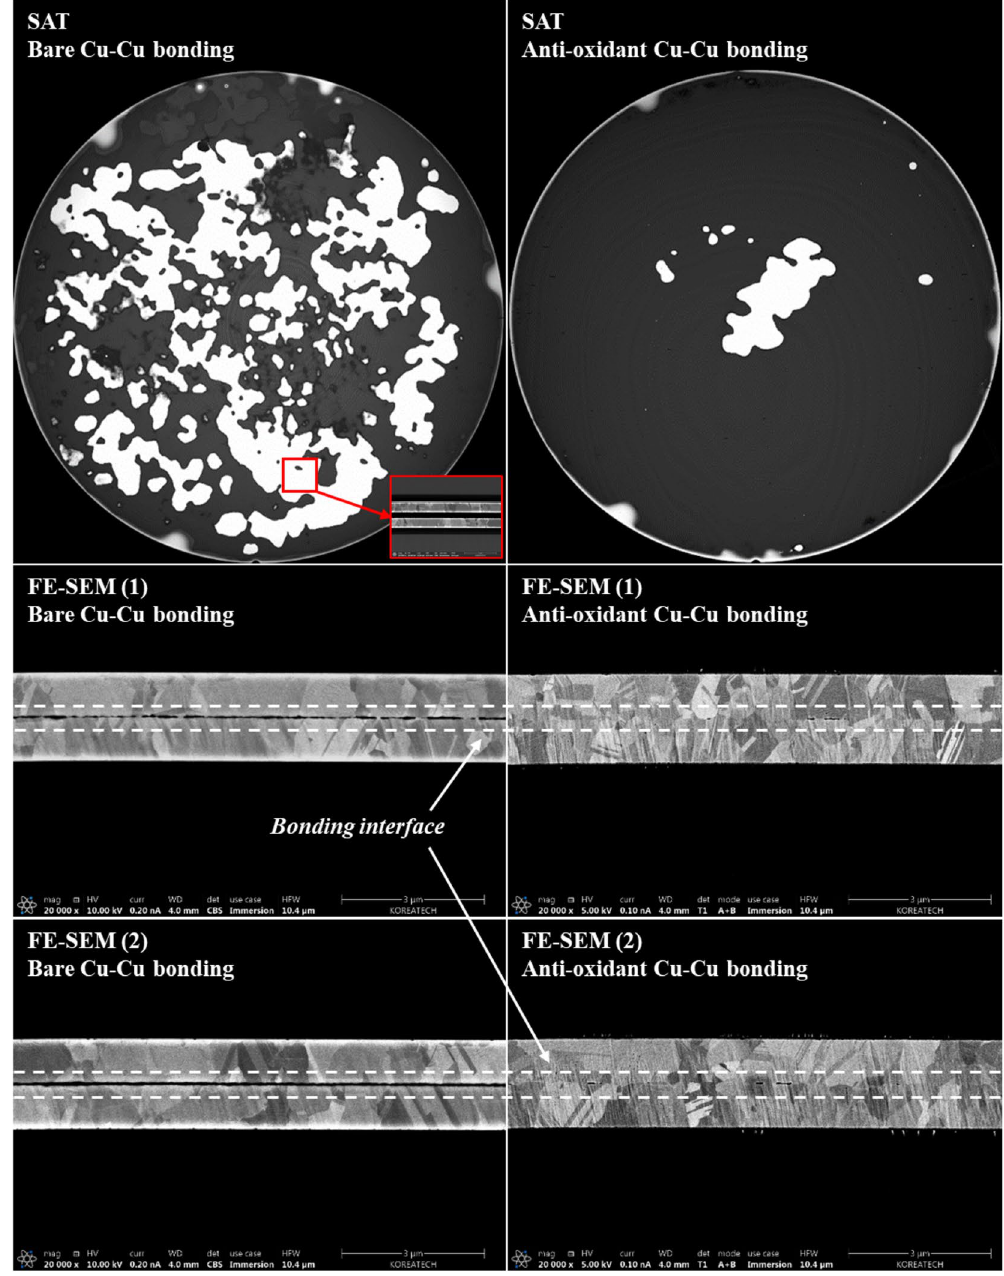
Figure 8. SAT and FE-SEM evaluation of the Cu–Cu interface bonded at 300 °C: (left) bonding with non- plasma treated Cu wafers and (right) bonding with two-step plasma treated Cu